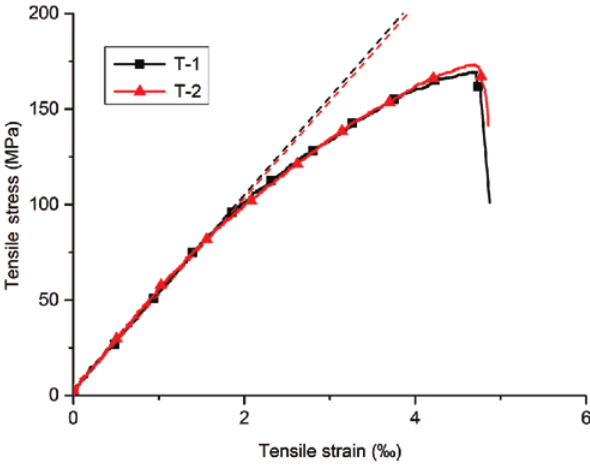
Figure 15: Stress-strain data of experiment.